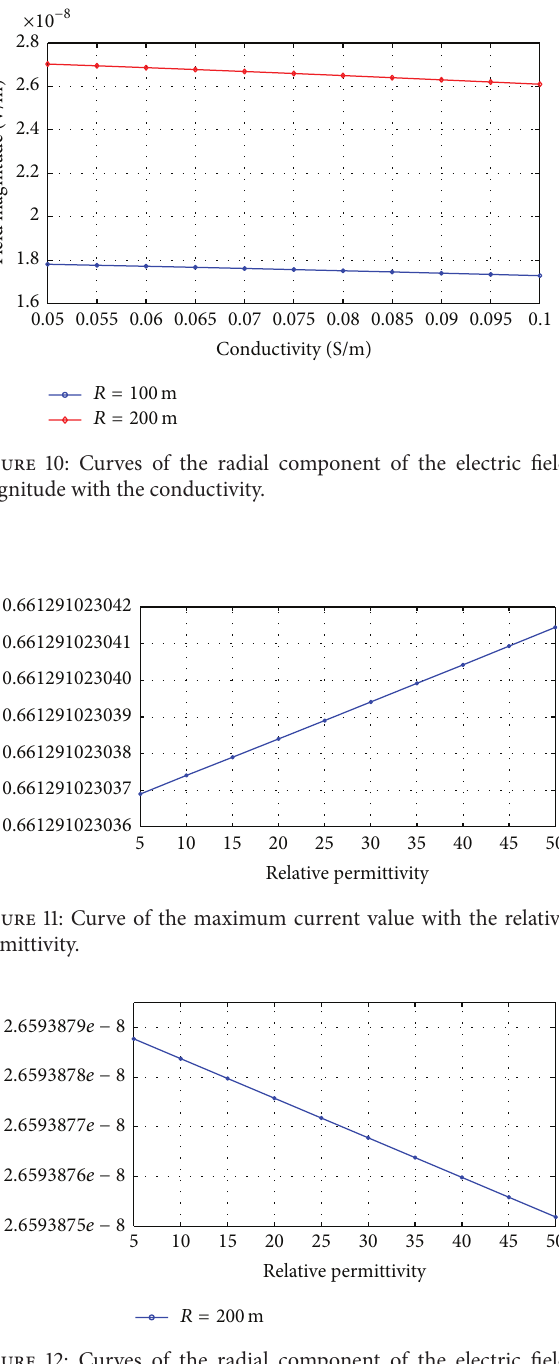
Figure 12: Curves of the radial component of the electric field magnitude with the relative permittivity.